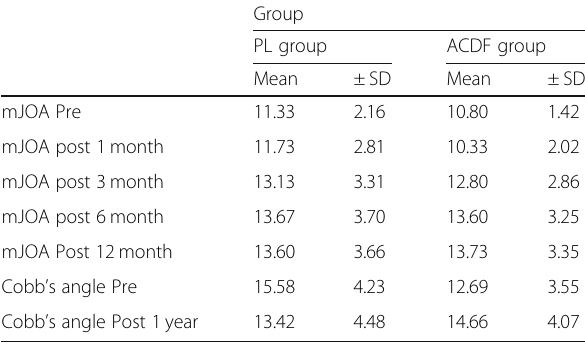
Table 6 Comparison between preoperative and postoperative mJOA scores and Cobb ’ s angle mean values in both groups Group